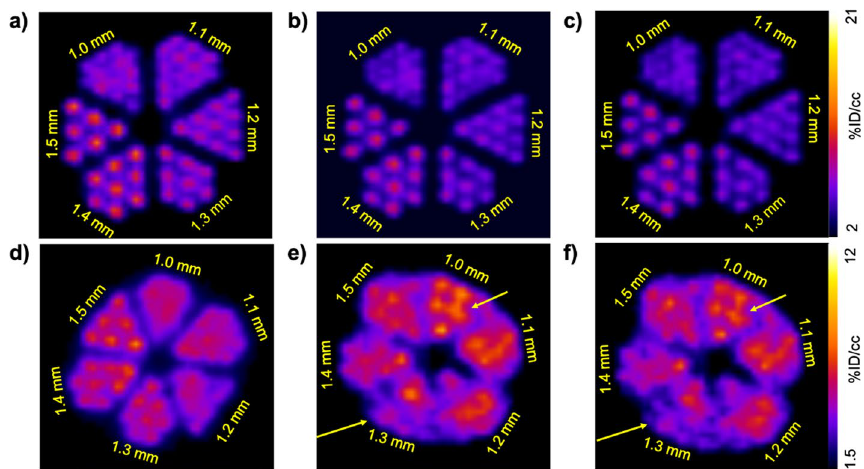
Fig. 5 PET respiratory gating in the presence of small motion artifacts. a A Derenzo phantom (Phantech Medical) was filled with ~ 3.7 MBq (100 µCi) of fluorine-18, attached to a lever, and placed in the axial center of the PET insert inside the MRI scanner. A 15 min PET/MRI scan was performed with no phantom motion. b The phantom was artificially moved up and down about 3–4 mm inside the PET insert continuously throughout a 15 min PET/MRI scan to mimic the spatial scale of mouse respiratory motion. PET image reconstruction without respiratory gating produced very slight blurring. c PET image reconstruction with respiratory gating led to minimal PET image quality improvement. d The phantom with ~ 3.7 MBq (100 µCi) of gallium-68 was attached to a lever and placed in the axial center of the PET insert inside the MRI scanner. A 15 min PET/MR scan was performed with no phantom motion. e The phantom was artificially moved up and down about 3–4 mm inside the PET insert continuously throughout a 15 min PET/MR scan. PET image reconstruction without respiratory gating produced intense image blurring. f PET image reconstruction with respiratory gating led to sharpening of image resolution (yellow arrows)